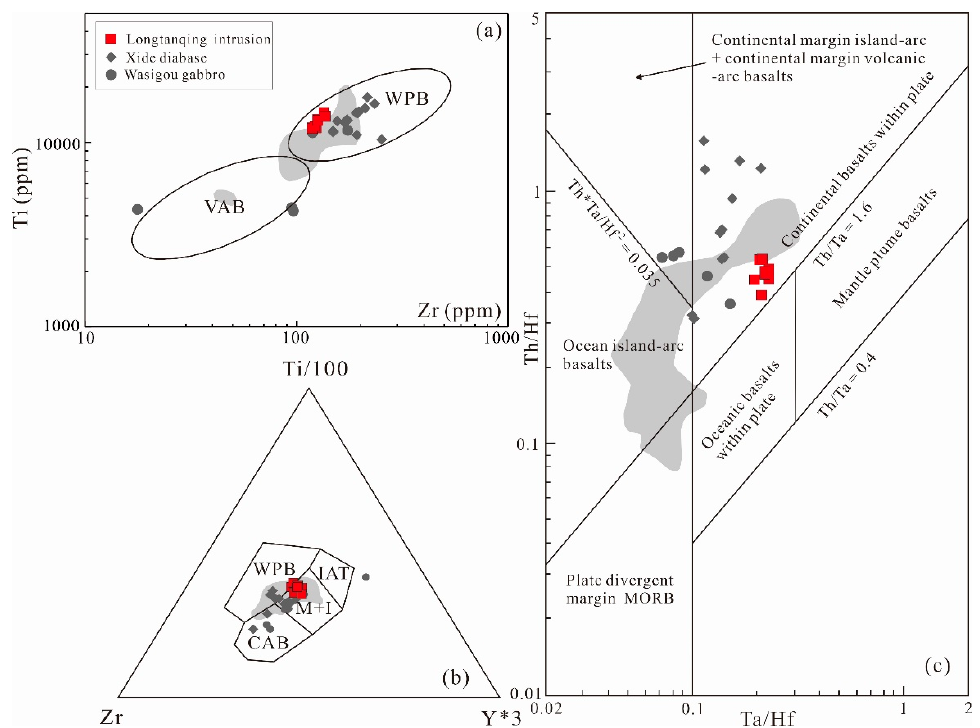
Figure 12. V–Ti discrimination diagram of [120] for the basic rocks from Longtanqing, Xide, and Wasigou, western YZB. The shaded areas outline the ranges of compositions for basic-ultrabasic rocks from the Hannan Massif of the northwestern YZB with data source from [45].